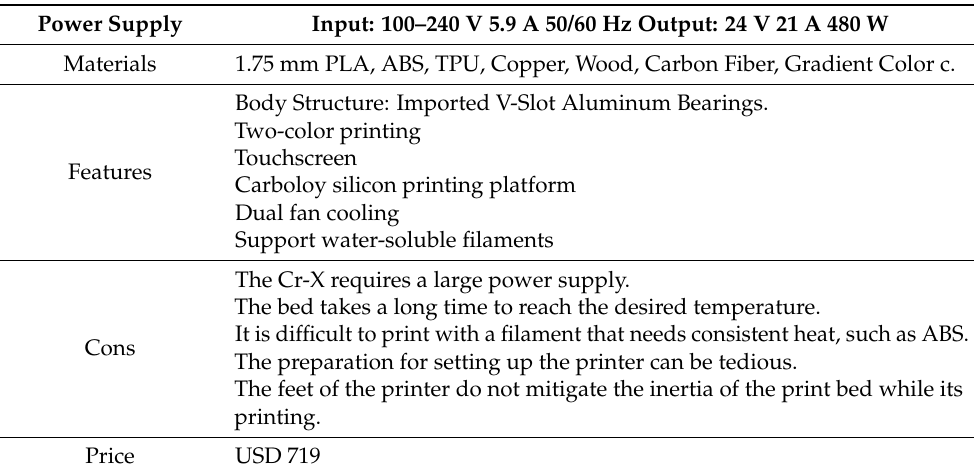
Table 5. Descriptions of Creality 3D Cr-X Desktop 3D